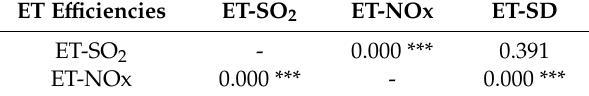
Table 4. Wilcoxon-Mann-Whitney test.